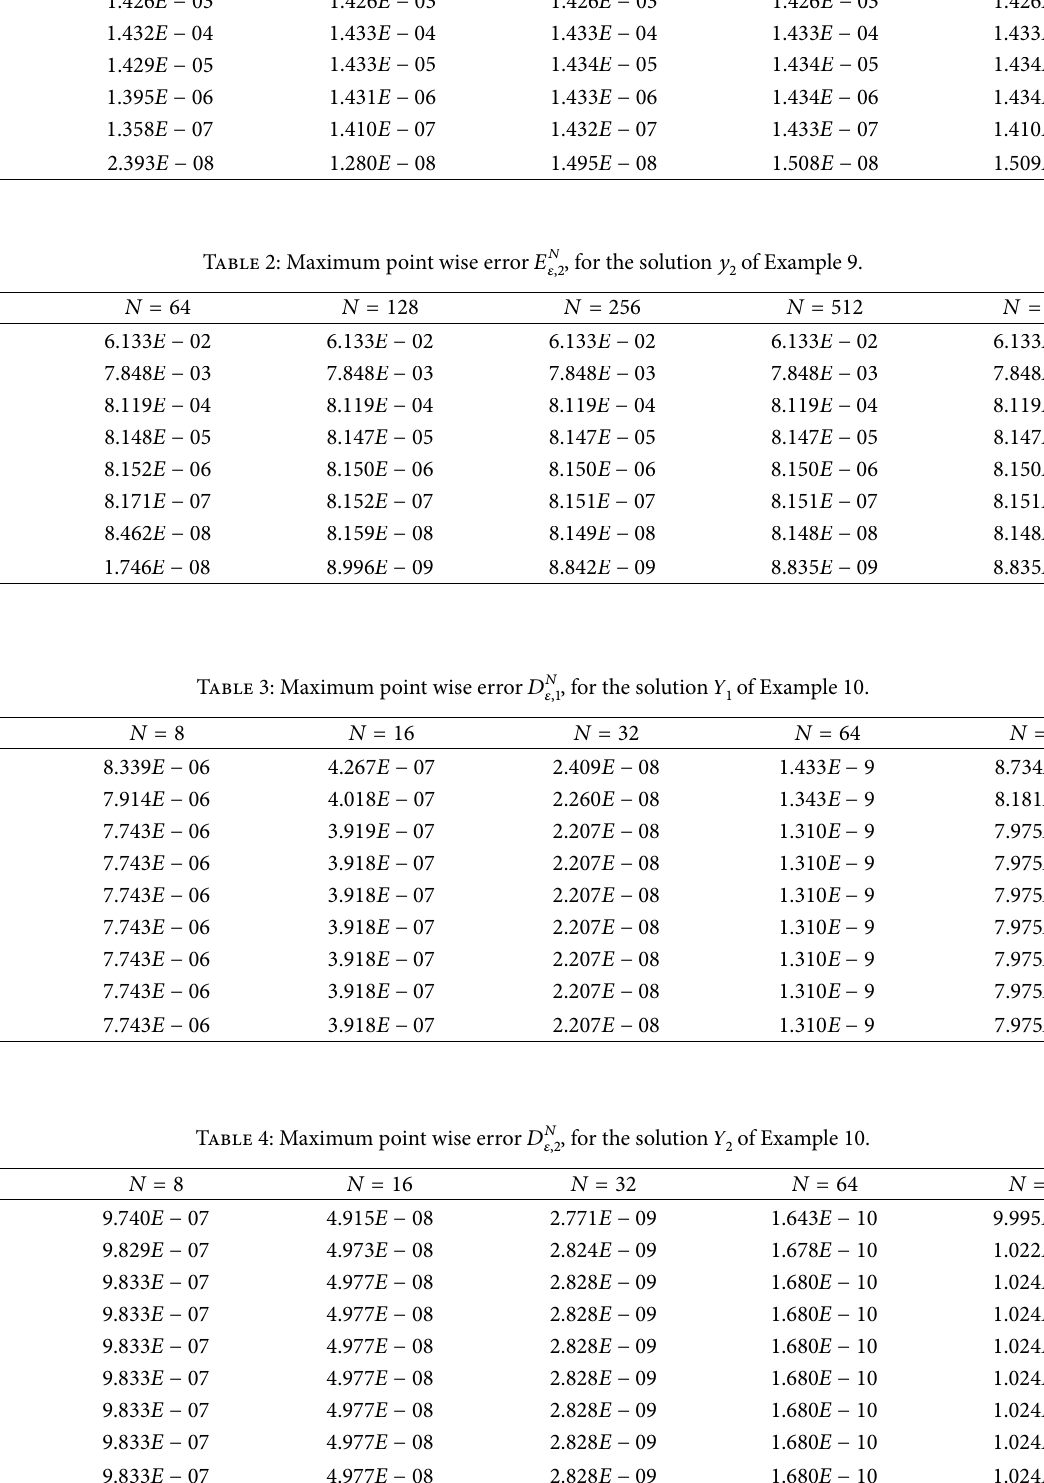
푁 , for the solution 휀,1 𝐸